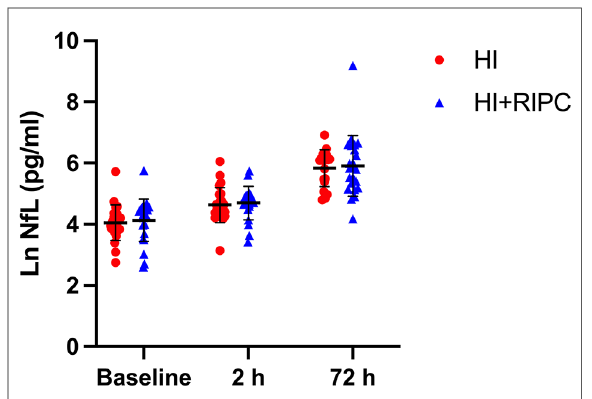
FIGURE 3 Serum NfL in piglets randomized to supportive treatment only (red circles) or supportive treatment+RIPC (blue triangles) at baseline/ pre-HI, 2 h after HI and 72 h after HI. Paired t test revealed no signi fi cant difference in NfL levels at any time point for piglets treated with RIPC vs. supportive treatment only ( p =0.58 at 72 h). Lines represent means and errorbars are standard